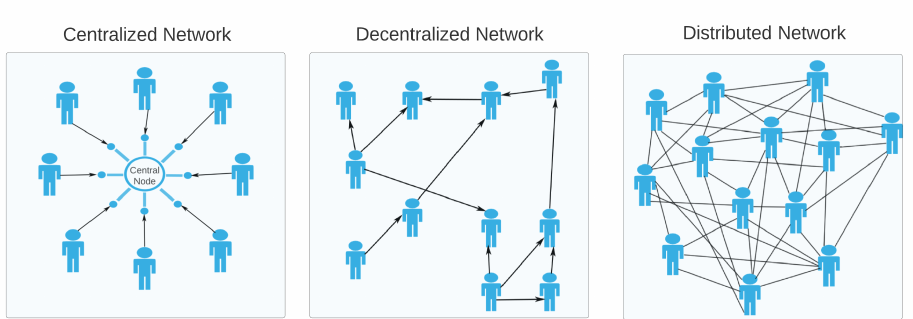
Figure 1. The different types of networks. Centralized networks have a central node that provides connection capabilities for the entire network. Decentralized networks have multiple connection paths between nodes, but some nodes can still lose connection with the network. Distributed networks have several communication paths between nodes, which drastically reduces the probability of a node disconnecting. Centralized is the most common, but decentralized and distributed are increasing in